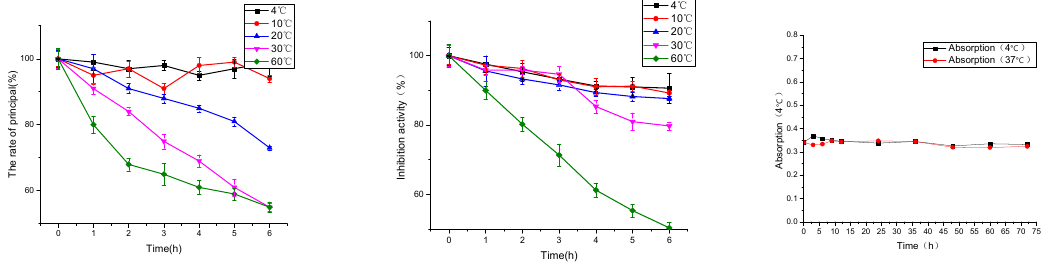
Figure 6. E ff ect of temperature on the peanut peptide (principal component and hypotensive activity) and multivesicular liposomes.